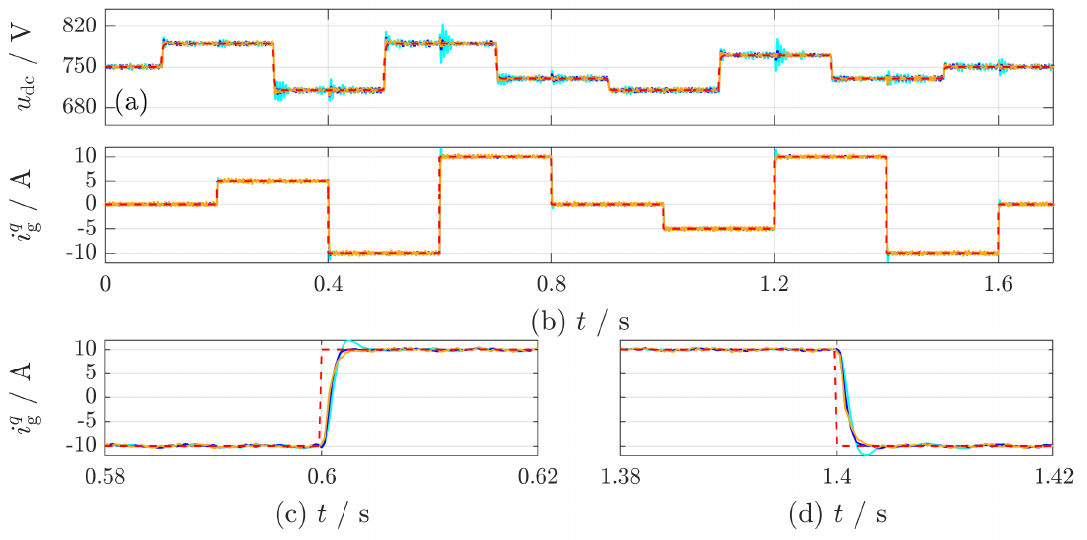
Figure 12. Experiment (E4) — Simulation results of proposed controller under grid inductance uncertainties. ( a , b ) time sequences of simulative results of the controlled states u dc and i q g ; ( c , d ) show zoomed